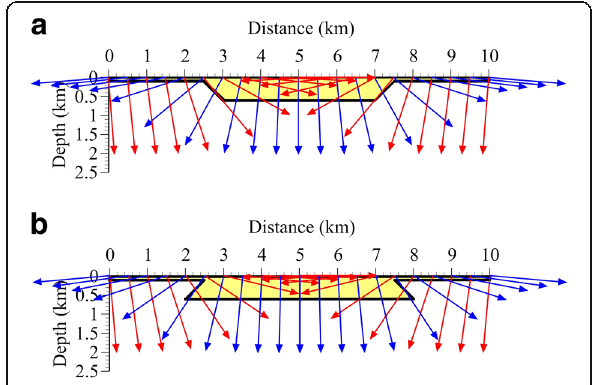
Fig. 6 Eigenvectors of the gravity gradient tensor caused by the simplified sedimentary basin models shown in Fig. 5. The maximum eigenvector and minimum eigenvector are indicated by red and blue , respectively. a Eigenvectors on the sedimentary basin formed by normal faults. When the sedimentary layer is in contact with the basement by normal fault, the dip of the maximum eigenvector follows the dip of the normal fault. b Eigenvectors on the sedimentary basin are formed by reverse faults. When the sedimentary layer is in contact with the basement by reverse fault, the dip of the minimum eigenvector follows the dip of the reverse